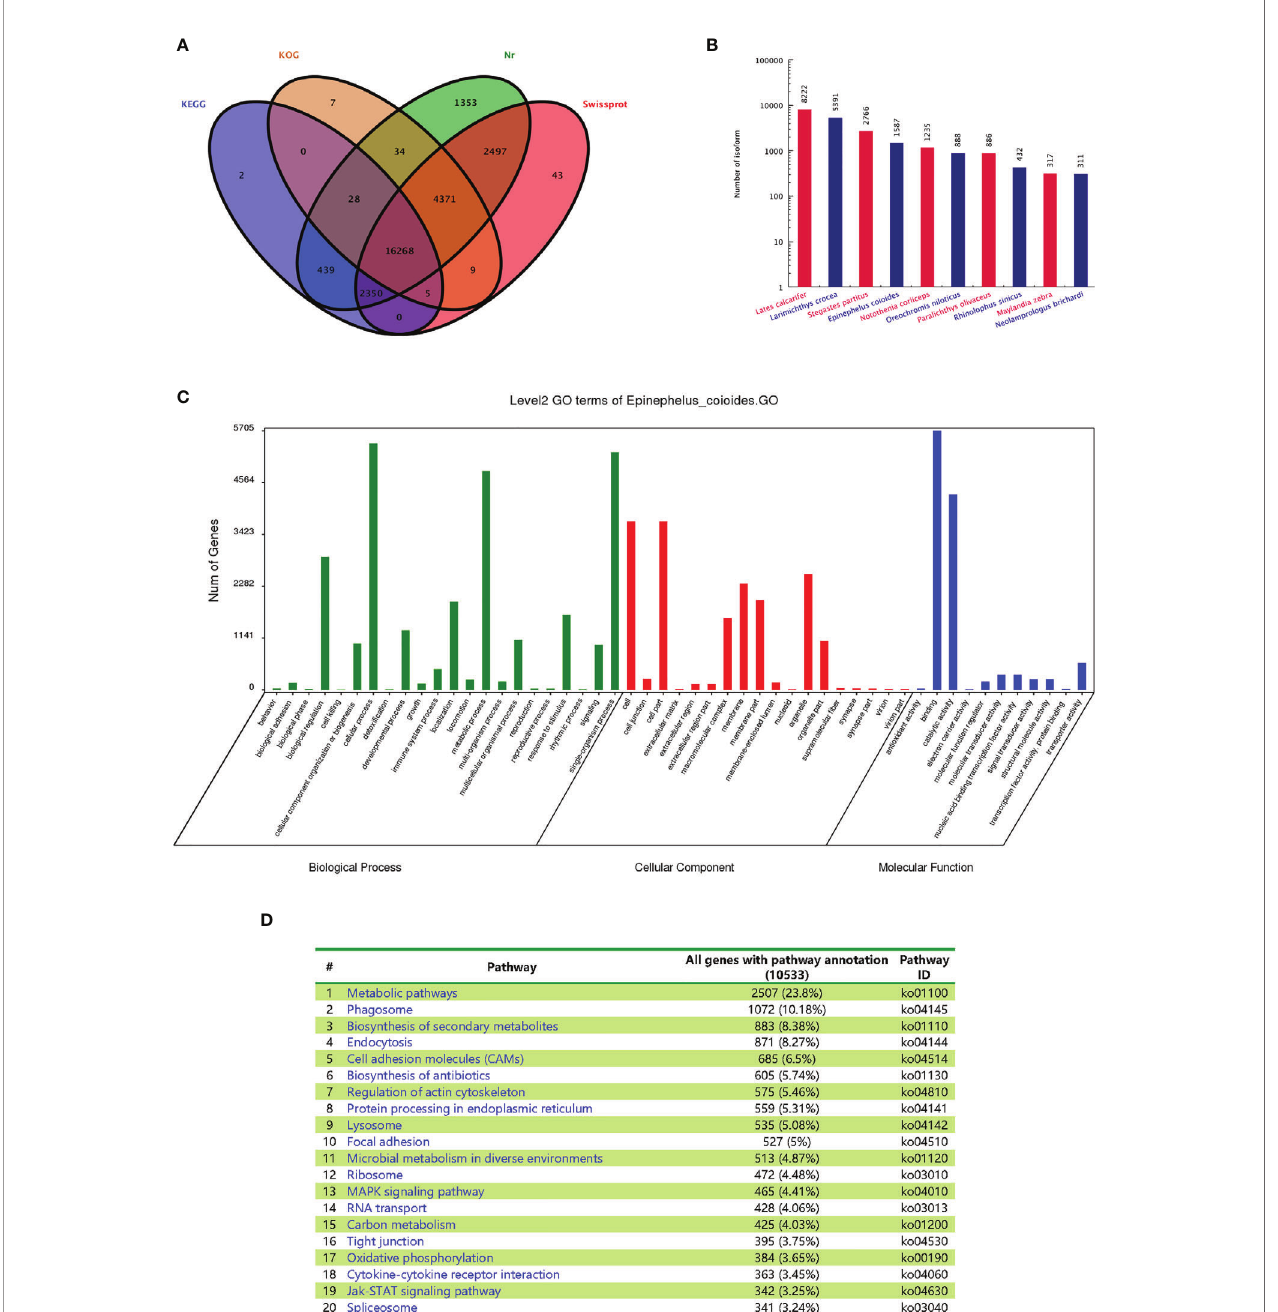
FIGURE 4 | Functional annotations of the full-length transcripts with Nr, SwissProt, GO and KEGG. (A) Venn analysis of annotation results of four databases: Nr, Swiss Prot, KEGG and COG/KOG. (B) Statistical map of species distribution (only the top 10 species are shown): after comparing isoform sequences with the Nr database by BlastX, the sequence with the best (lowest E value) hit to the isoform in the Nr database was taken as the corresponding homologous sequence to determine homologous sequences of the species. The number of homologous sequences of each species was statistically compared. (C) Go function classi fi cation chart. (D) Distributions of the KEGG